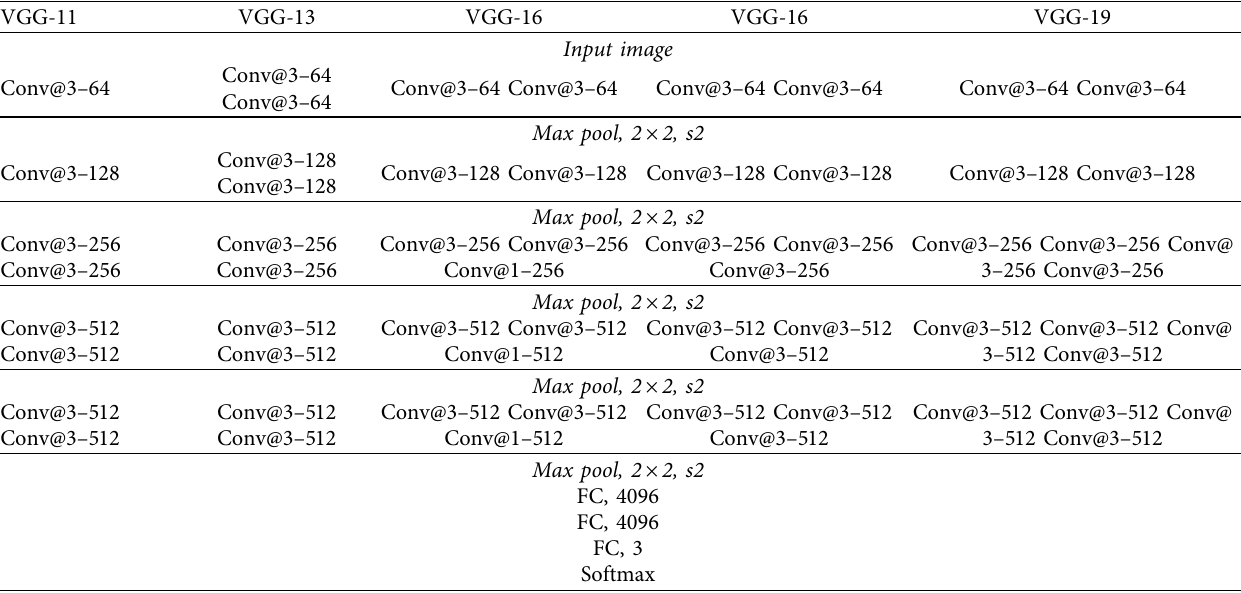
Table 2: Architectures of VGGNets. The added layers are shown in bold, and the ReLU is placed after each weight layer, which is not shown for